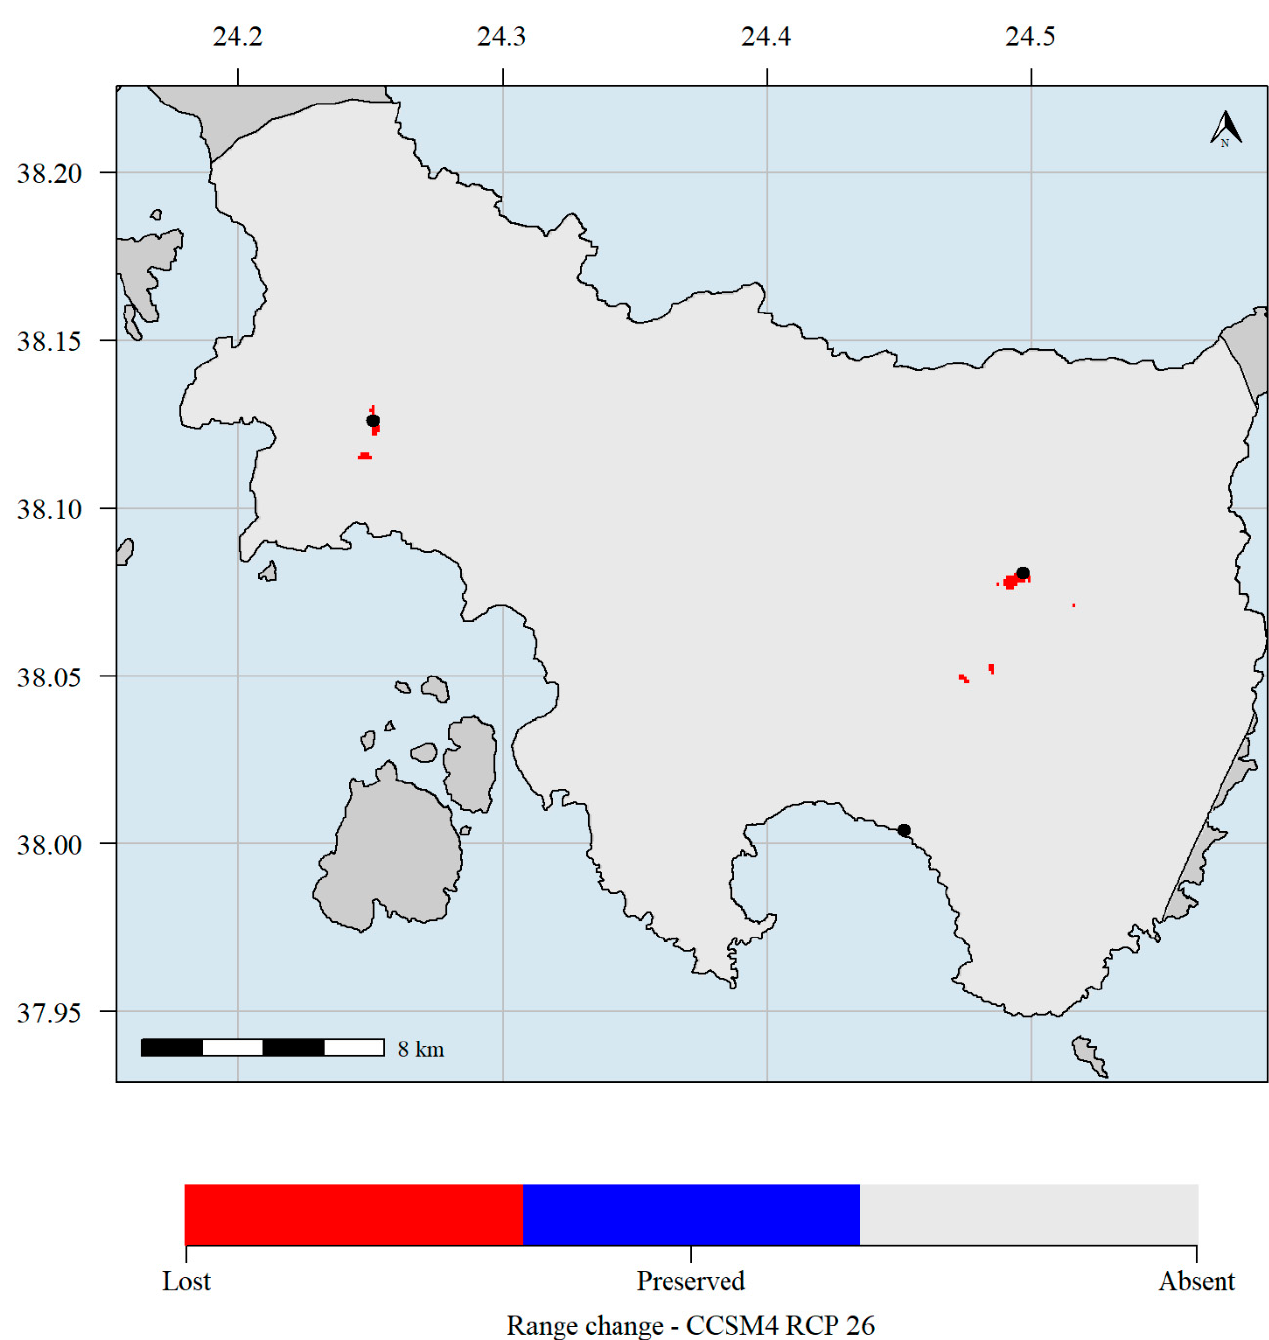
Figure 7. Predicted potential distribution map for 2070 and the CCSM4 GCM and the RCP 2.6 scenario. Red grid cells: Allium iatrouinum is currently predicted to occupy these areas but will not occupy them in the future. Blue grid cells: Allium iatrouinum is currently predicted to occupy these areas and will continue to occupy them in the future. Light grey grid cells: Allium iatrouinum is not currently predicted to occupy these areas and it is not predicted to occupy them in the future. Black dots indicate the occurrences of Allium iatrouinum in Evvia. Climate data refer to the WorldClim database. Please note that the black dot in southern Evvia hides the red cell where the species is predicted to currently occupy.